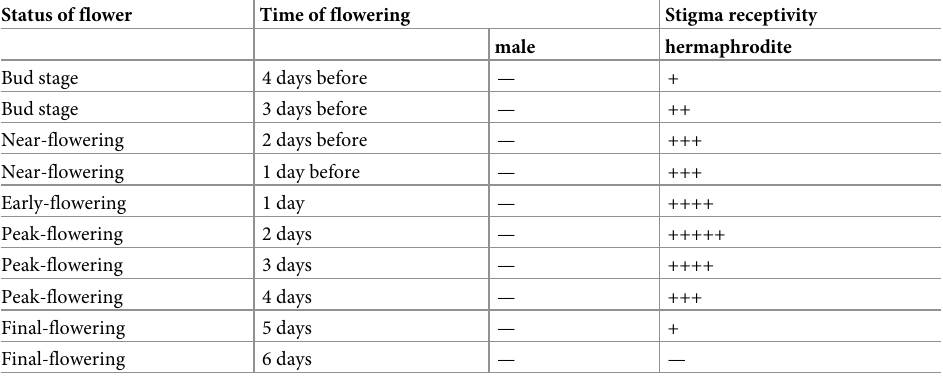
Table 5. Stigma receptivity of male and hermaphrodite flowers of O . delavayi in Yunnan. Status of flower Time of flowering Stigma receptivity